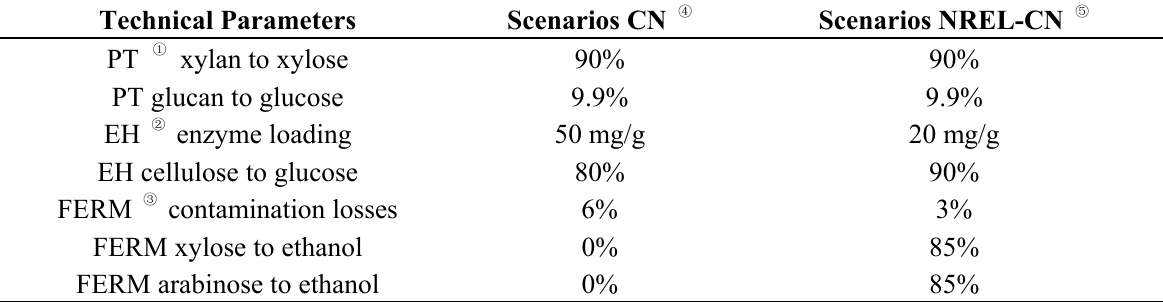
Table 4. Key technical